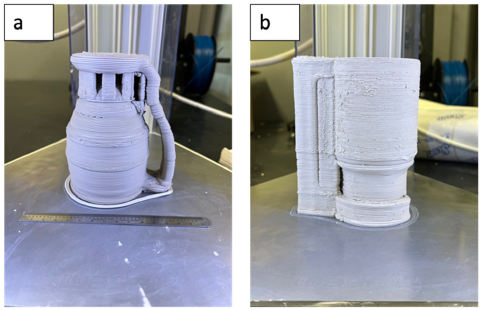
Figure 3. Initial ( a ) and redesigned ( b ) model